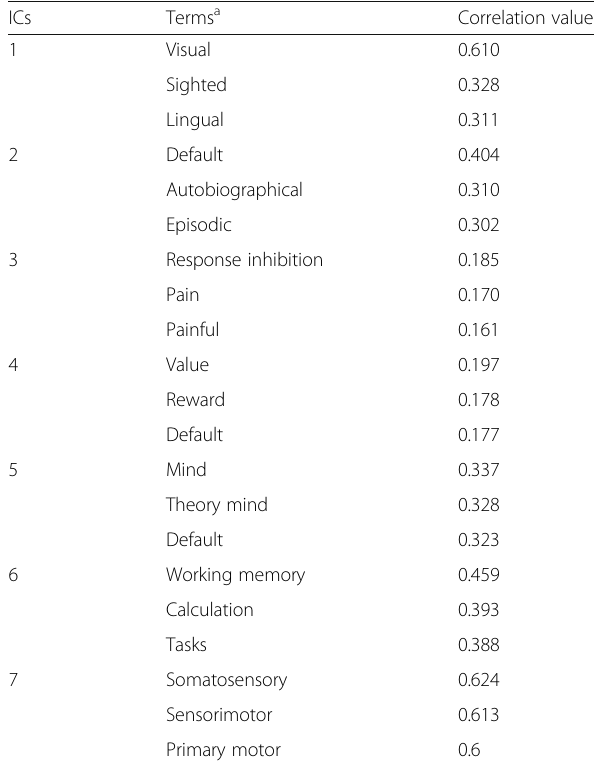
Table 2 The results of the cognitive decoding process of the ICs using Neurosynth software